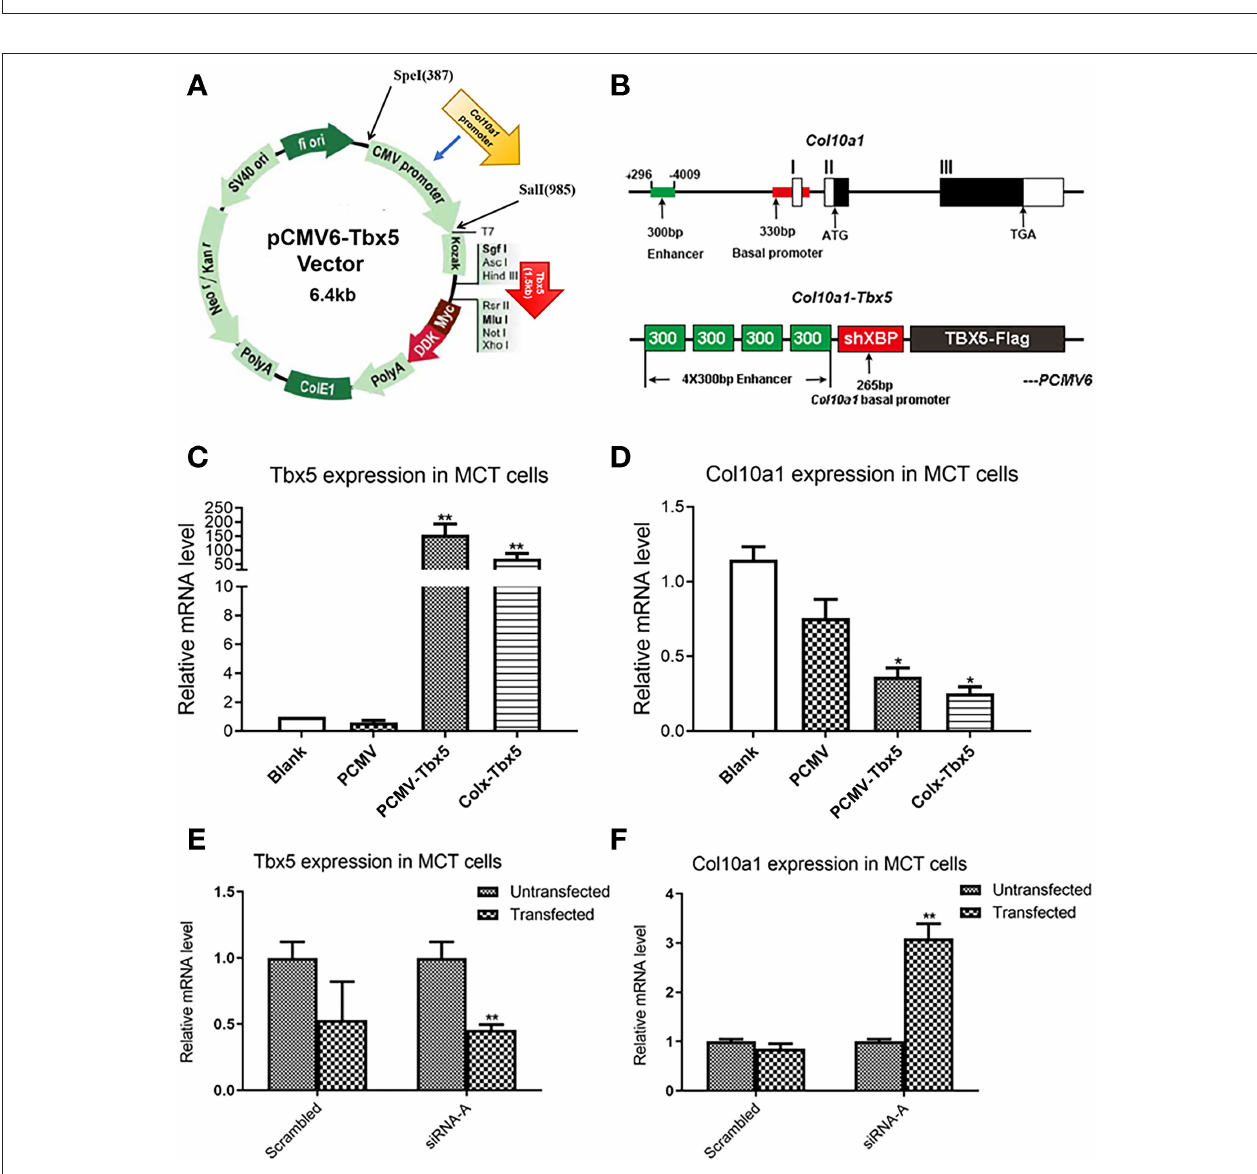
FIGURE 3 | normalized to β -actin in hypertrophic vs. proliferative MCT cells. (C) Strong green fluorescence signal indicating Col10a1 protein expression was observed throughout the hypertrophic zone. Dlx5, Egr2, Gklf, and Sox17 protein were also abundantly expressed in hypertrophic chondrocytes, with some Sox17 signal also seen in resting or proliferative chondrocytes. Tbx5 signal was much weaker in hypertrophic chondrocytes compared with that of other TFs. (D) Immunohistochemistry analysis detected strong Col10a1 expression only in the extracellular matrix of hypertrophic chondrocytes (top row), whereas no obvious Tbx5 expression was detected in either proliferative or hypertrophic chondrocytes. * p < 0.05, ** p < 0.01.